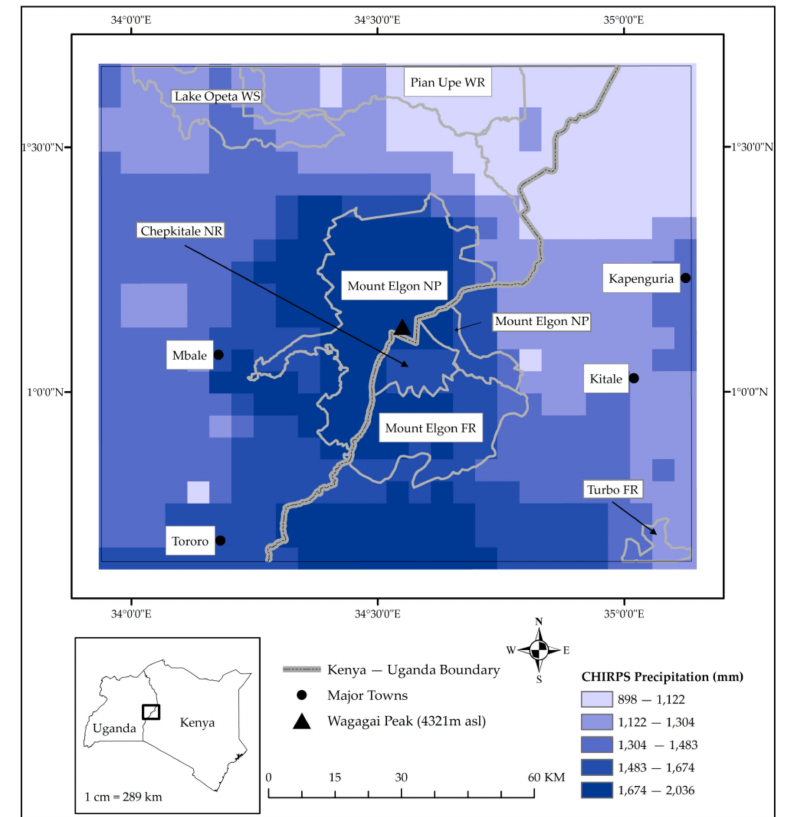
Figure 2. Map of the MEE in eastern Uganda and western Kenya showing long-term (1986–2018) mean annual total precipitation (CHIRPS [53]). Generally, the driest parts are the grasslands in northeastern MEE. The study area is wettest in the south and around the mountain region. Major protected areas and towns are shown for reference. FR is shorthand for forest reserve, NR is national reserve, NP is national park, WS is wetland system and WR is wildlife